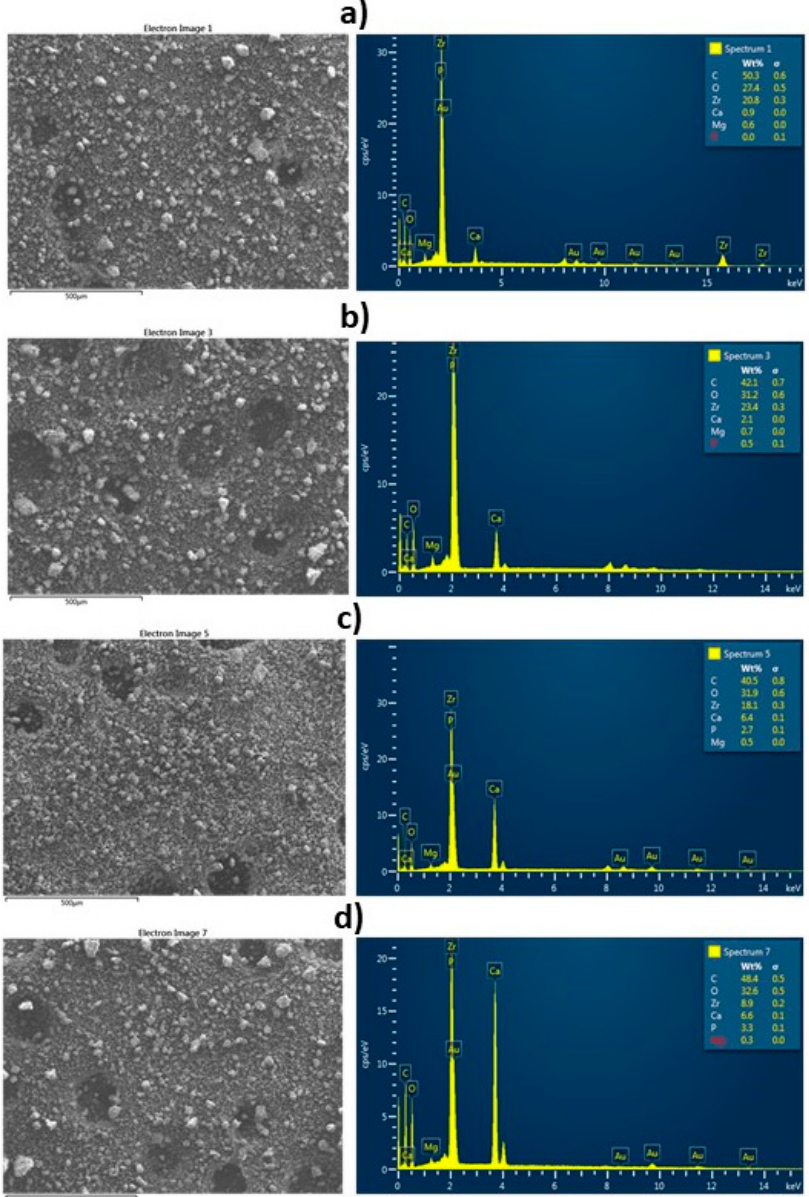
Figure 2. SEM images (left) and EDS analysis (right) for S2 (a), S3 (b), S4 (c) and S5 (d) composites.